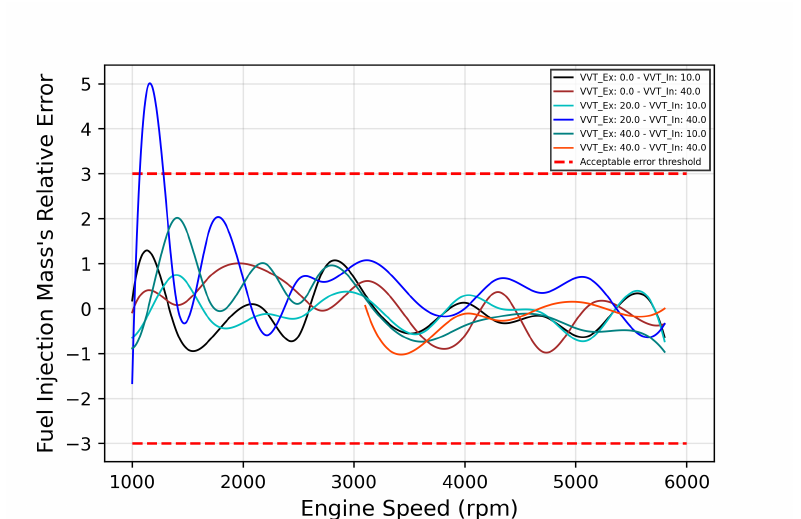
Figure 13. Fuel Injection Mass’ Relative Error Graph.